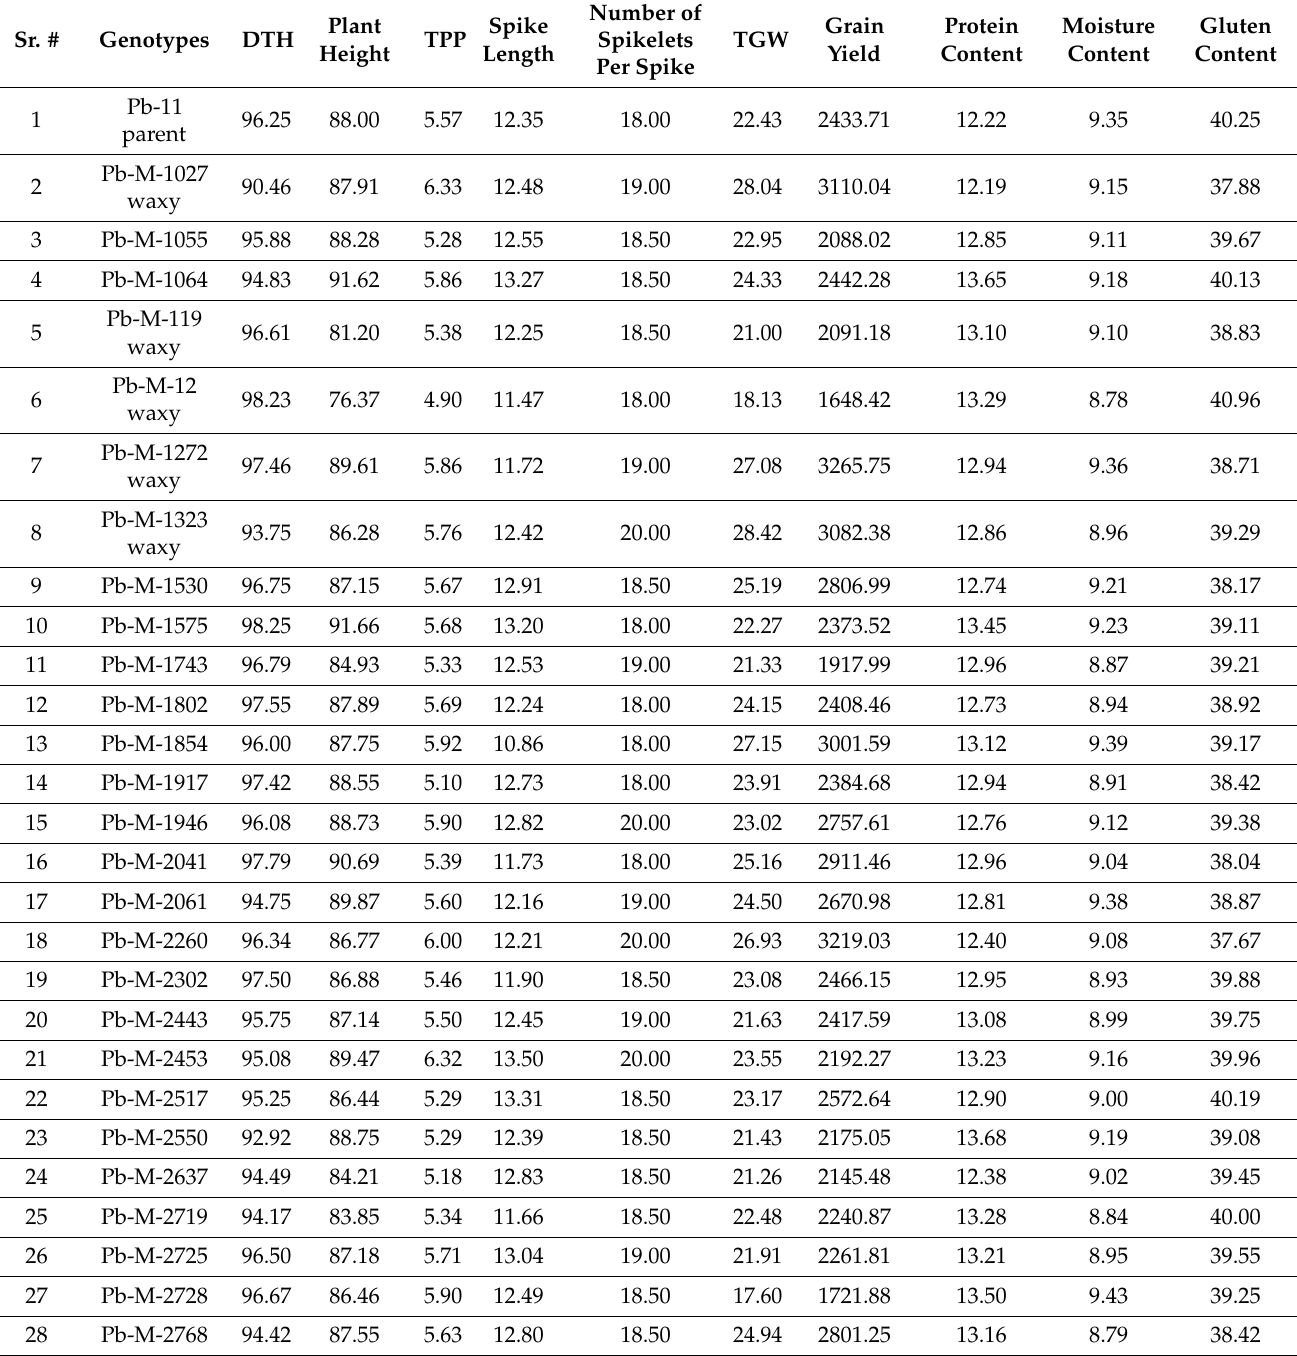
among all mutant lines. Protein contents varied from 12.19 to 13.68%, moisture contents ranged between 8.73 and 9.43%, while gluten contents ranged from 37.67 to 40.96 (Table ?? ). The mean values for all traits differed from the values for the wild type; however, the maximum fluctuation was found for the relative reductions in grain yield (34.36% for Pb-M-59 waxy and − 29.25% for Pb-M-12 waxy), followed by TGW. The mean values for the mutants for gluten and moisture contents showed reductions compared to those for the wild type, except for two mutants (Table S1). Table 5. Mean performance of 32 mutant lines and the wild type for two generations (M 7 and M 8 ) and locations (NIBGE and